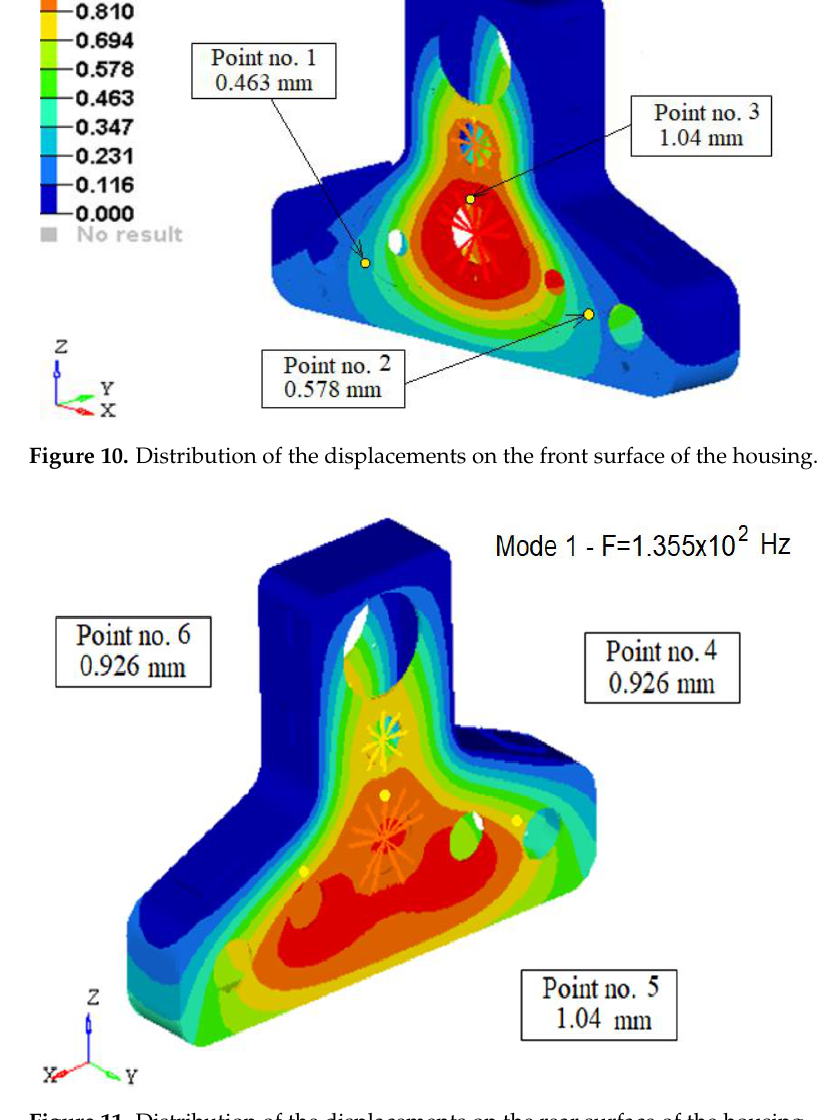
Figure 11. Distribution of the displacements on the rear surface of the housing.